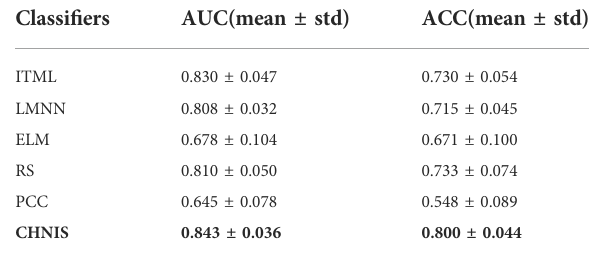
TABLE 2 Comparison of extrapolation